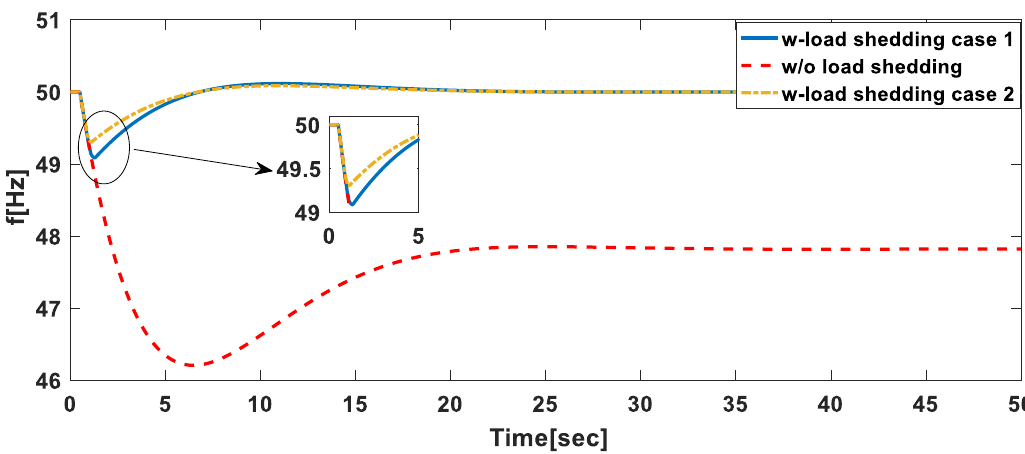
Figure 5. The amount of load to be shed in the first scenario: a comparison between cases 1 & 2.